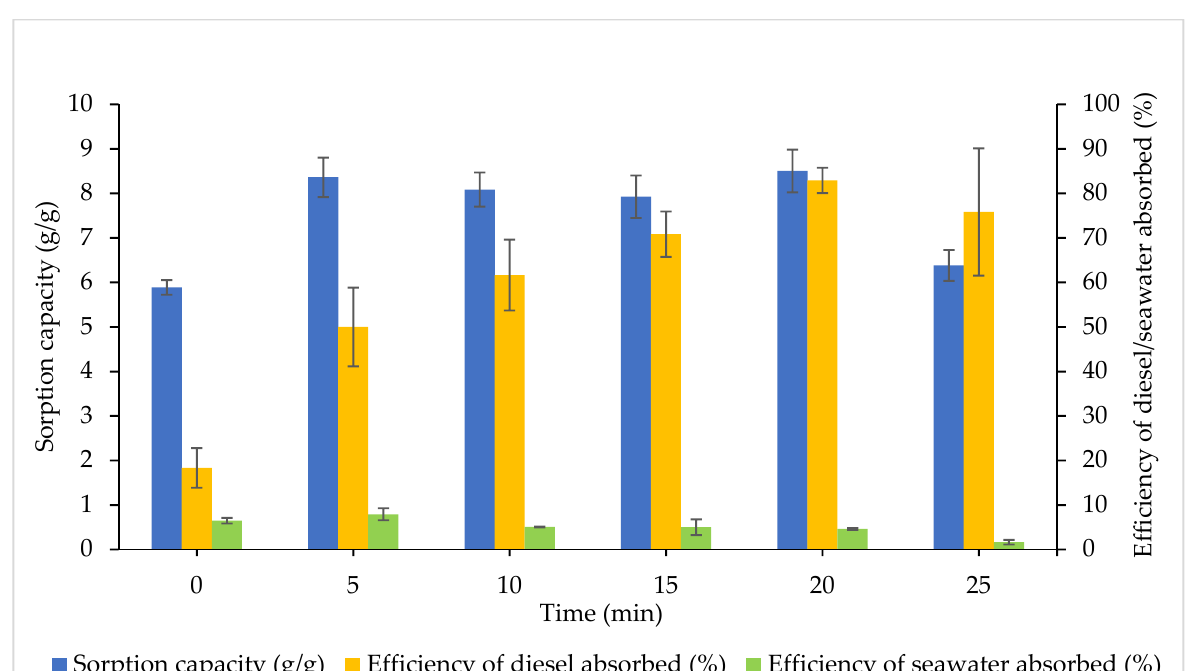
Figure 6. Effects of heating time. The error bars represent the mean ± SEM for three replicates ( n = 3).